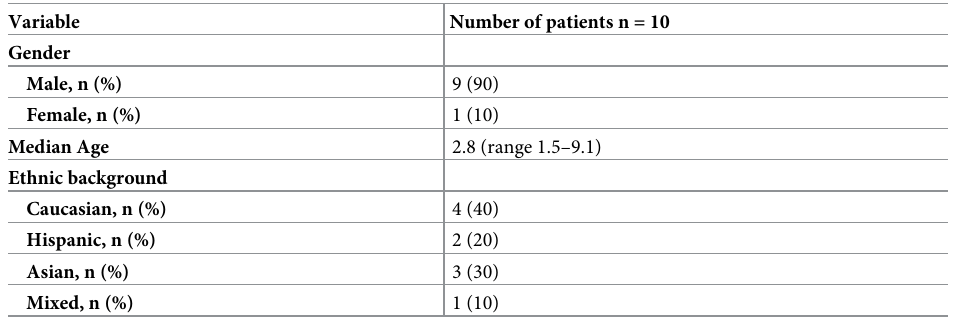
Table 1. Demographic details of the study